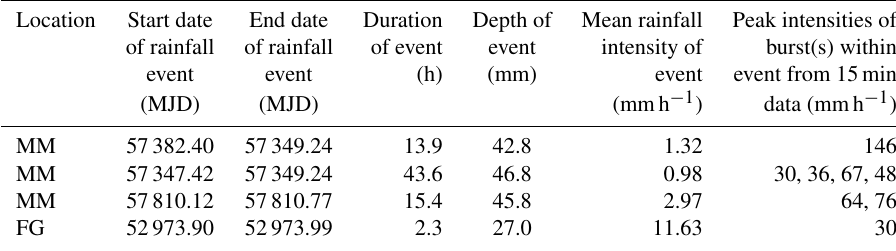
Table 1. Details of rainfall events defined using MIT = 6h, together with the mean rainfall intensity of the event and the peak burst intensities evident in data aggregated to 15min rainfall totals. See text for